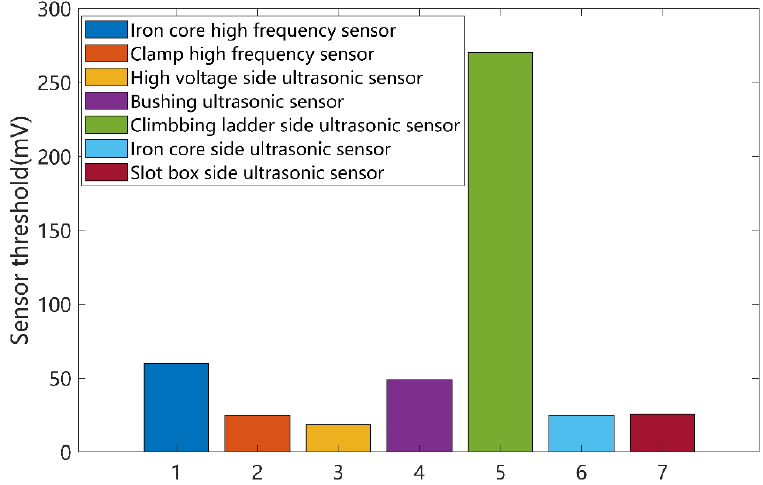
Figure 7. Partial discharge threshold setting of different sensors.